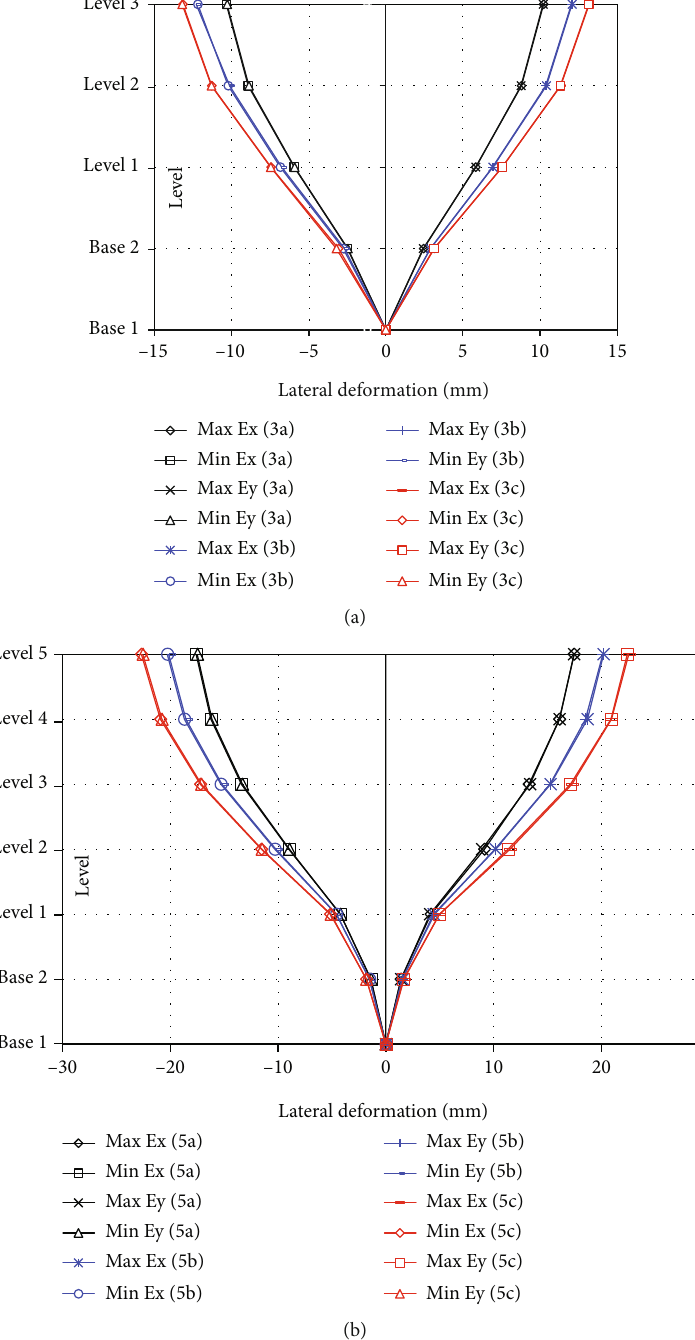
and E Earthquake for Meru levels (a) 3 and (b) x y